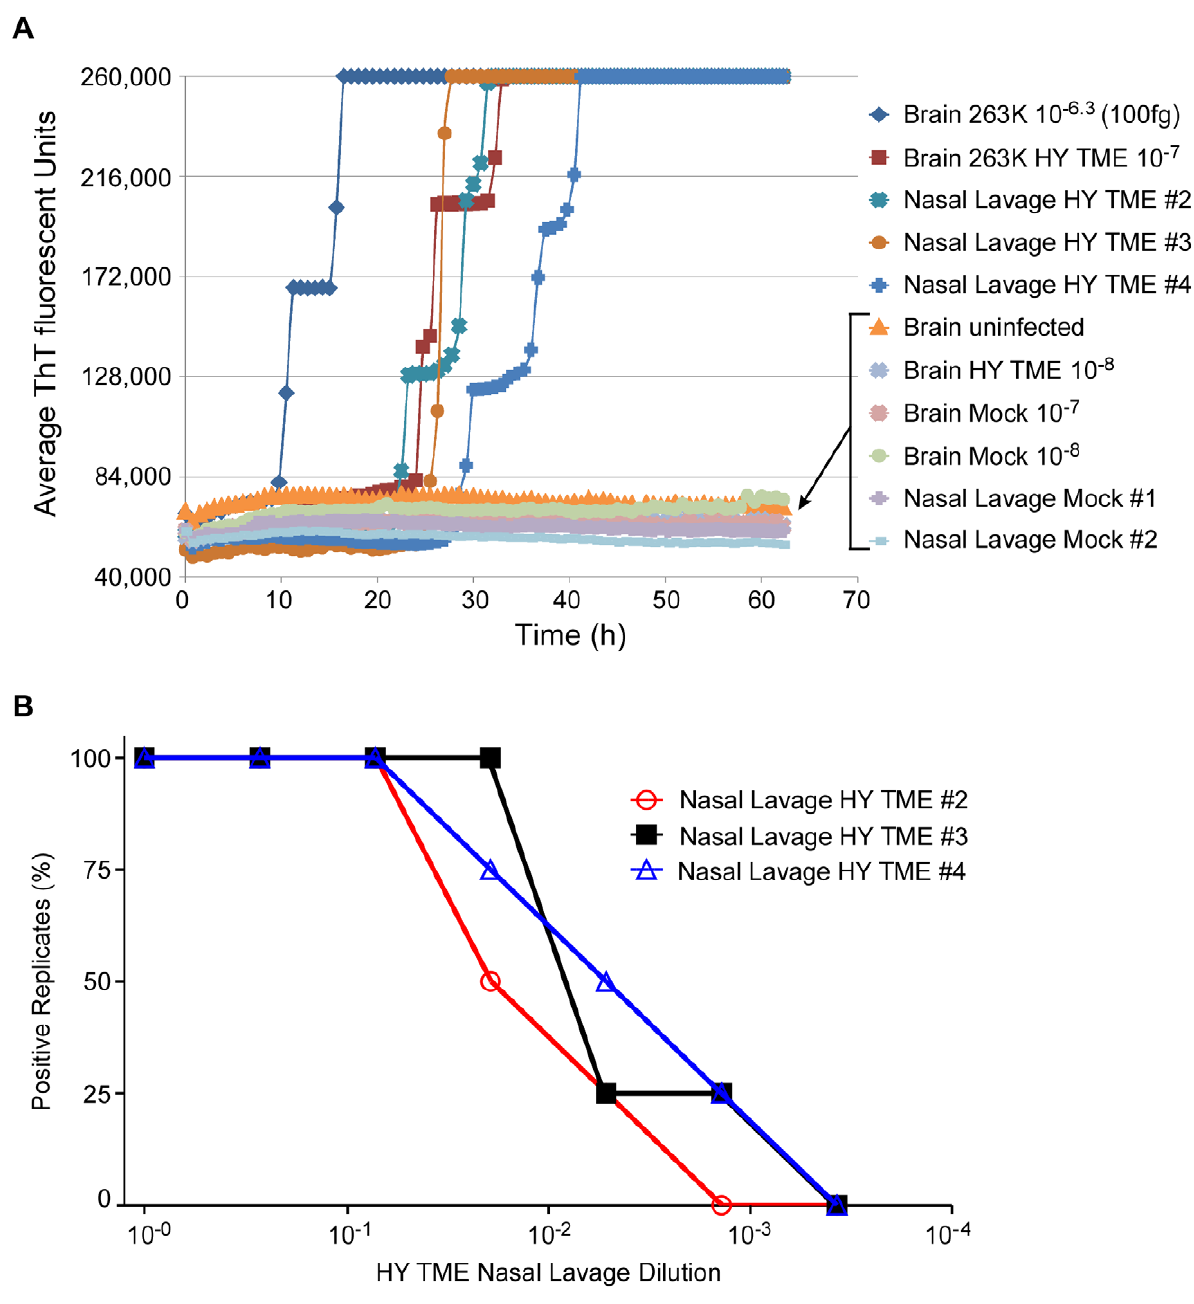
Figure 5. RT-QuIC detection and end point dilution analysis of nasal lavages from HY-TME-infected hamsters. At the clinical stage of disease in hamsters i.c.-inoculated with HY-TME, nasal lavage samples ( , 1 ml) were collected from individual hamsters, serially diluted and used to seed RT-QuIC reactions. (A) Detection of HY-TME in nasal lavages is shown. As positive and negative controls, 5 6 10 -6 -fold dilutions of hamster scrapie BH (containing , 100 fg PrP Sc ) and NBH, respectively, were used as seeds. Dilutions of HY-TME brain were also tested for comparison. The data points show the average ThT fluorescence of 8 replicate wells. (B) Three representative HY-TME infected hamster lavages were serially diluted and analyzed by RT-QuIC. Each data point represents the percentage of replicate wells (n=4) that are ThT-positive according to the criteria in Material and Methods as a function of nasal lavage dilution factor. The tabular data from lavages tested here can be found in Table 2.